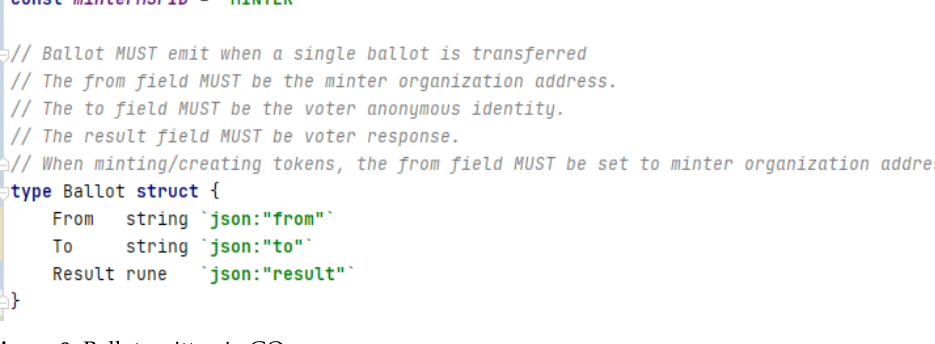
Figure 8. Ballot written in GO.